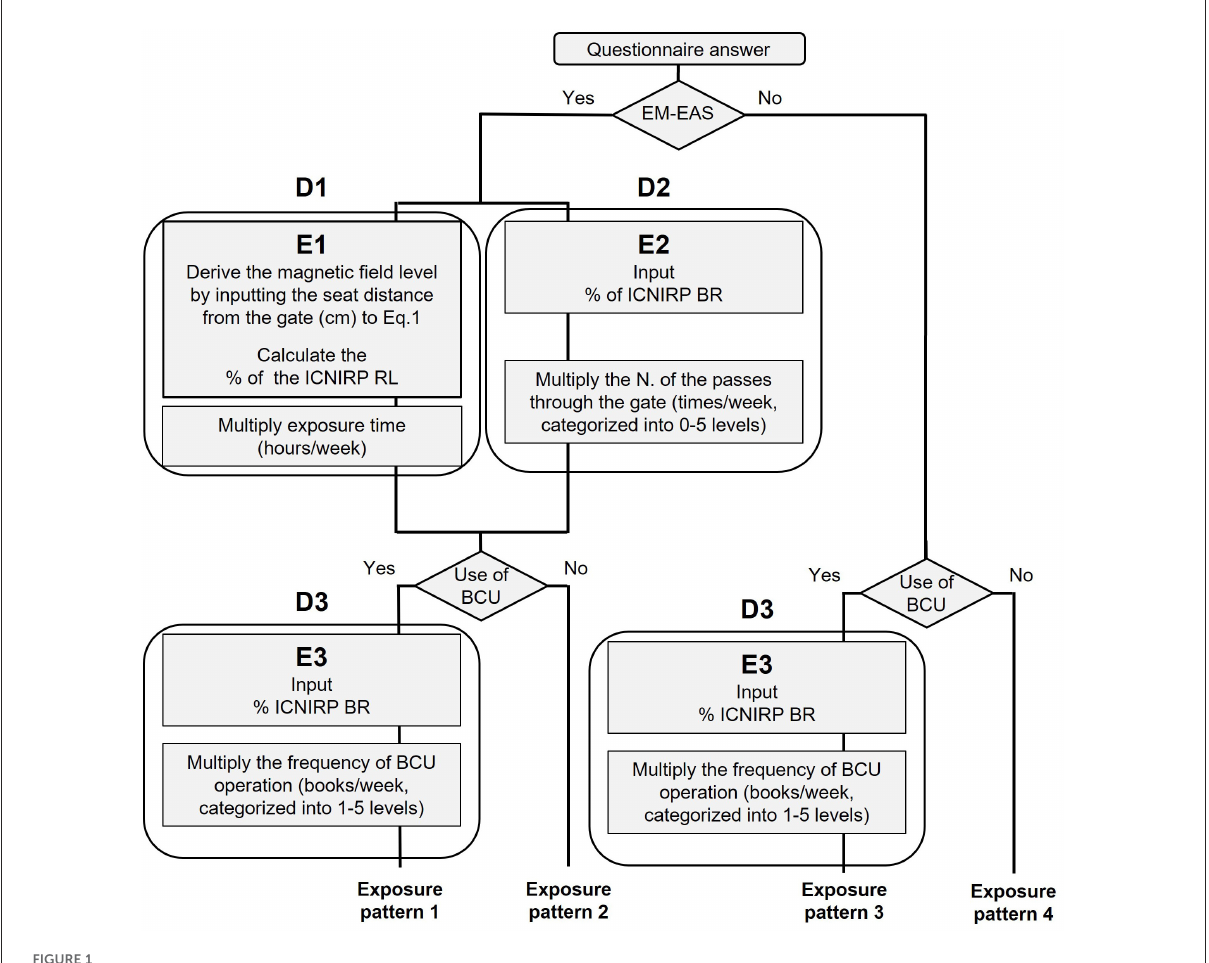
FIGURE1 The exposure scenario of library